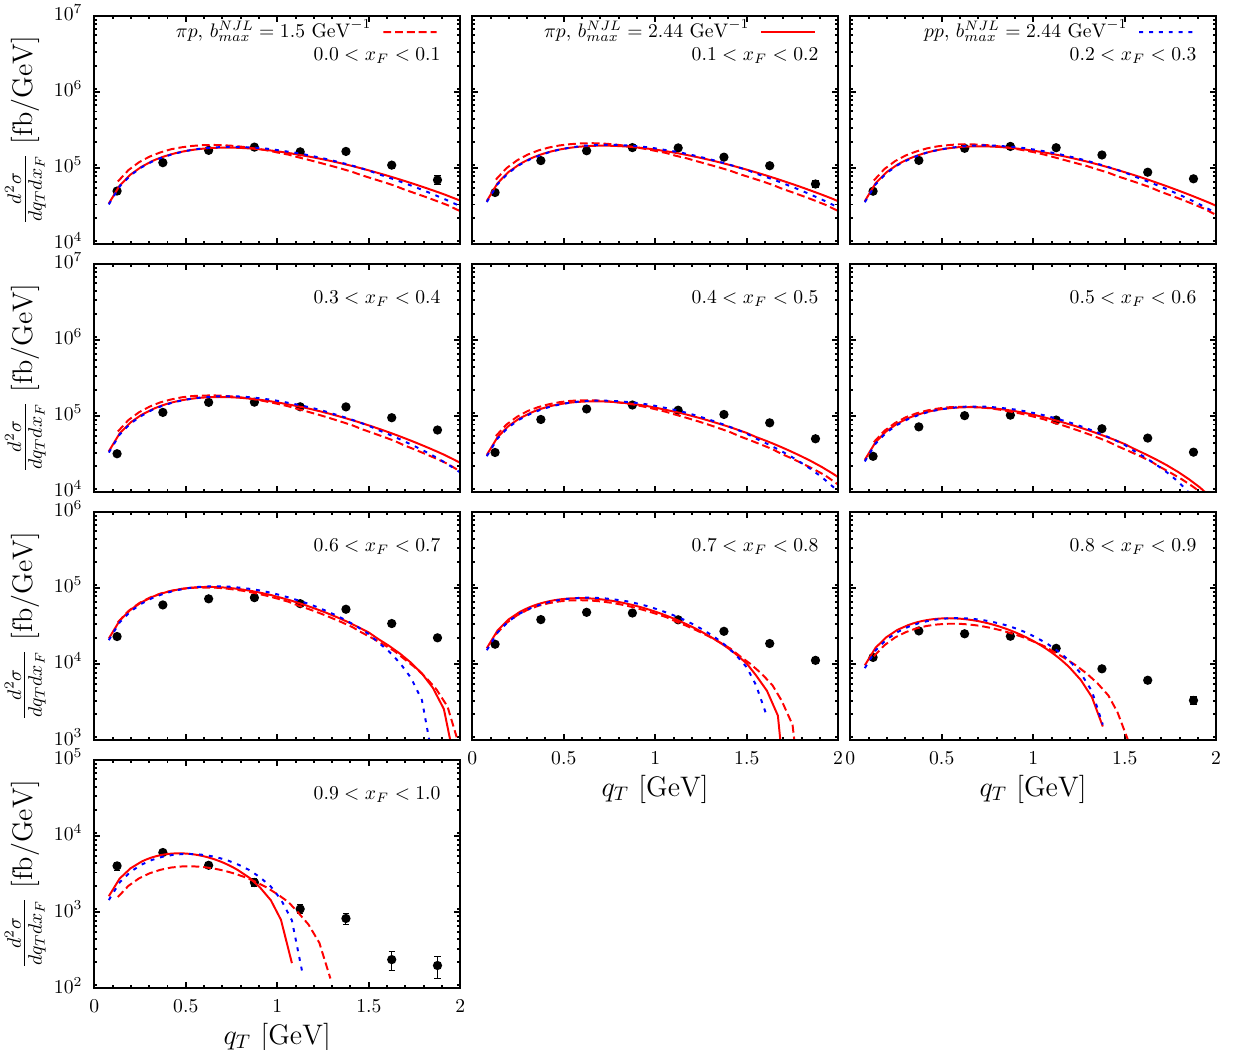
Fig. 5 Predictions compared to differential cross sections in various x F bins integrated in the mass range 4 < M < 8 . 55 GeV. Data from Refs.